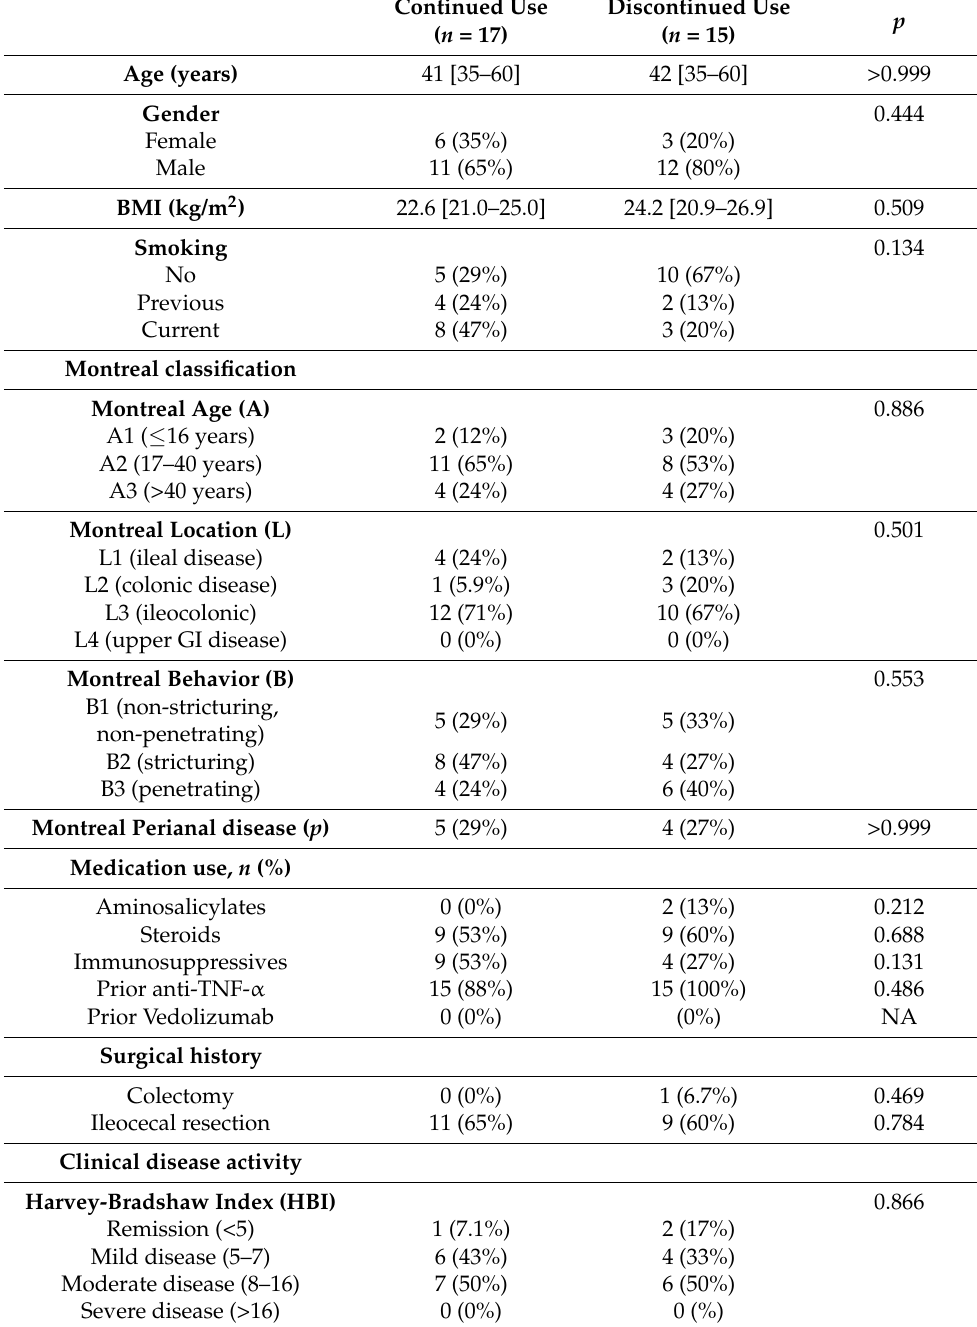
Table 1. Patient baseline characteristics and clinical demographics, stratified by long-term use of VEDO treatment as a surrogate outcome for sustained response to